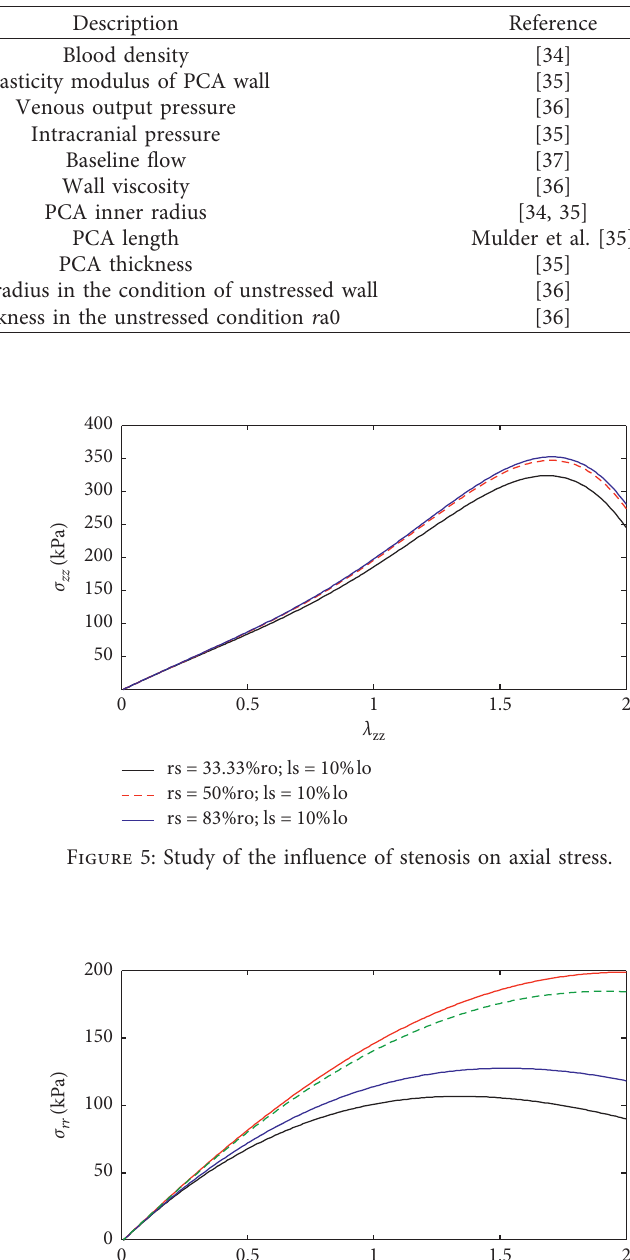
Table 1: Constant lumped parameters model symbol, value, unit, description, and reference.